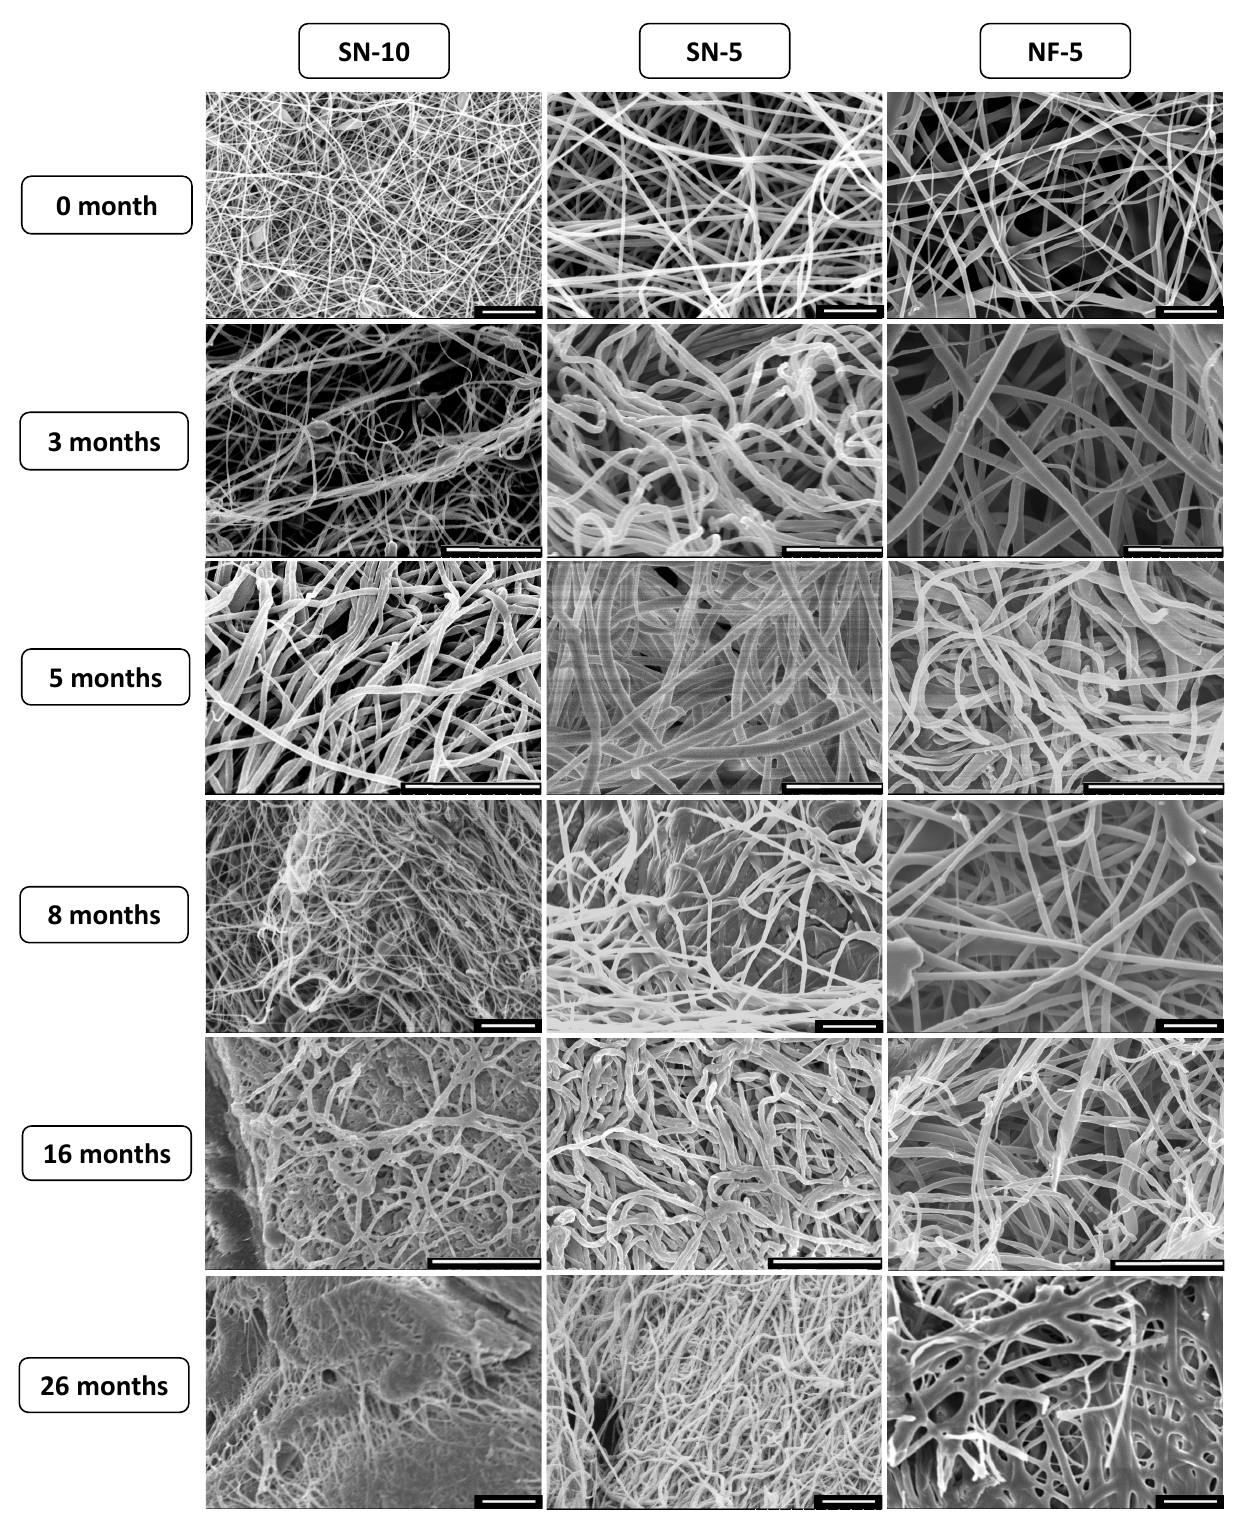
Figure 8. SEM images of the ciprofloxacin-loaded nanofibers taken during the 26-month stability study. The morphology of the nozzle-free nanofiber sample (NF-5) remained stable over the 26 months. For the nanofibers produced using a nozzle (SN-10 and SN-5), aging of the structure was observed at 16 and 26 months. The scale bar is 20 µm on every microscopic image.